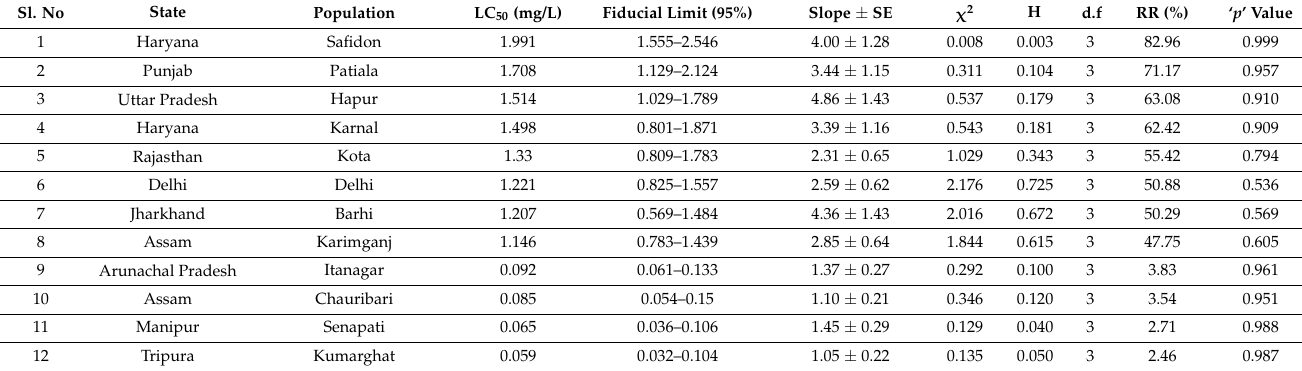
Table 2. Toxicity of phosphine in different populations of Rhyzopertha dominica